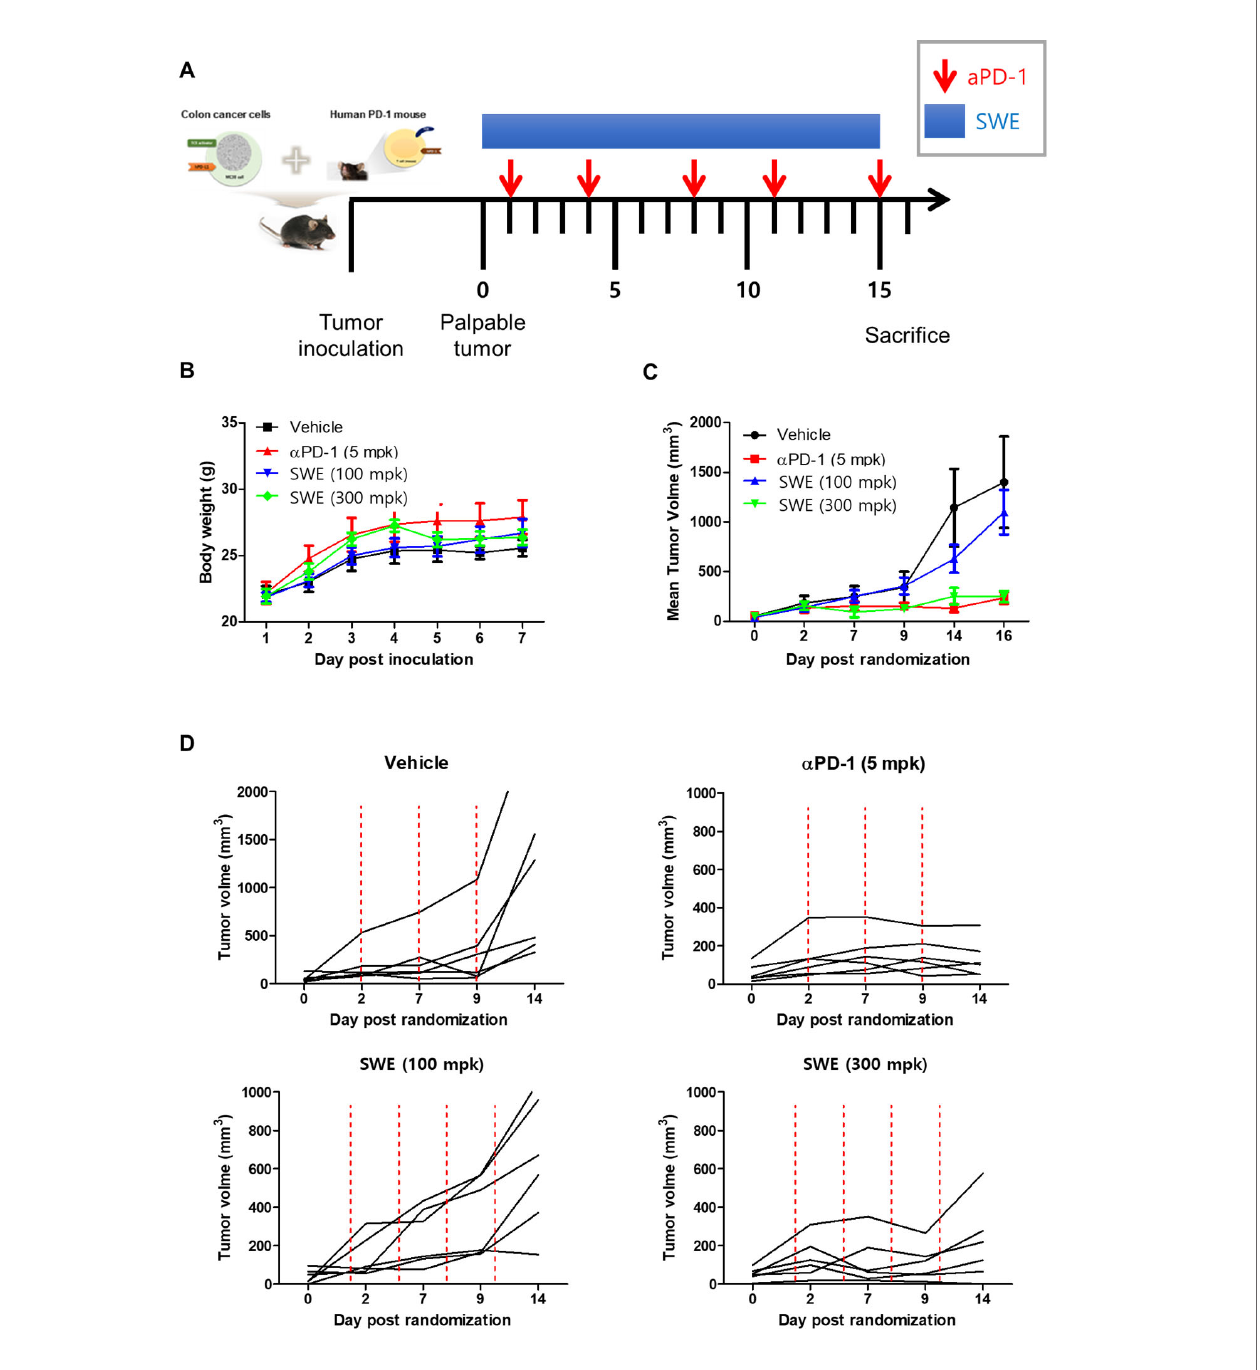
FIGURE 6 | SPE attenuated growth of hPD-L1 MC38 tumors in hPD-1 knock-in C57BL/6 mice. (A) Experimental scheme. The fi gure was adapted from a previous study and slightly modi fi ed (38). (B) Mean bodyweight. (C) Mean tumor growth curves. (D) The individual tumor growth over time for plot. MC38 cells expressing hPD-L1 (1.5 x 10 5 cells/mouse) were inoculated subcutaneously (day -14) into hPD-1 knock-in C57BL6/J mice. Once tumors became palpable (~100 mm 3 ), tumor- bearing mice were randomized into groups of 6 animals per group: an untreated control group (no tumor cells injected-group), and groups injected with MC38 tumor cells plus vehicle (PBS, 10 mL/kg, q.d., i.g.), Anti-PD-1 antibody with pembrolizumab (5 mg/kg, b.i.w.x2, i.p.), a low or high dose of SPE (100 or 300 mg/kg, q.d., i.g.). On days 1, 4, 8, 11, and 15 post implantation, mice were dosed intraperitoneally (i.p.) with PBS or anti-PD-1 antibody. Intragastric (i.g.) injection were daily given with SPE for 15 days. On day 16 post administration, all mice were sacri fi ced for in vivo analysis. Statistics were analyzed using two-way ANOVA with Bonferroni post-hoc test; ***P < 0.001, compared with the vehicle